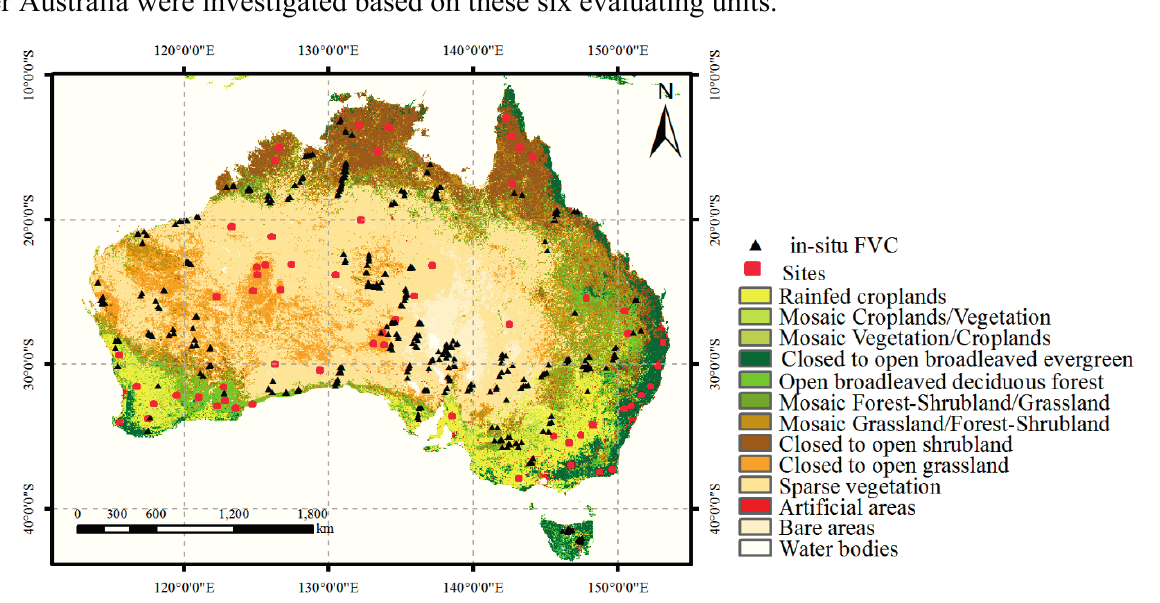
Figure 1. Spatial coverage of the evaluating units and in-situ fractional vegetation covers. The base map is the Glob Cover 2009 land cover